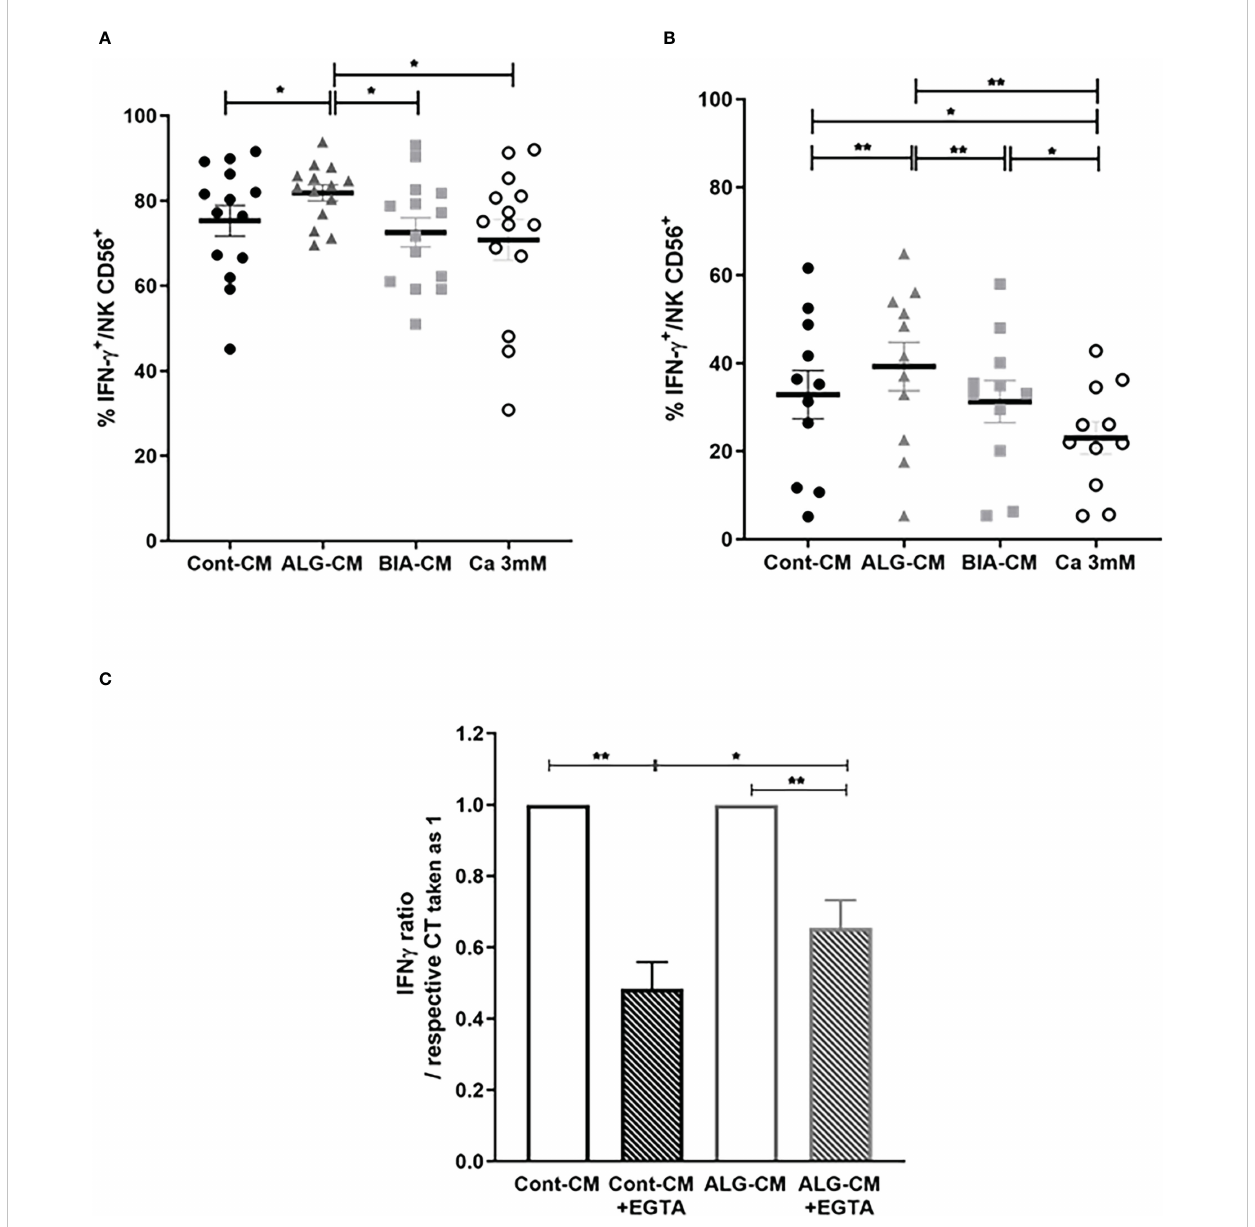
FIGURE 6 Effects of different sources of exogenous calcium on IFN- g production by NK cells. Flow cytometric detection of IFN- g production by puri fi ed CD56 + NK cells incubated for 24h in complete R10 medium with IL-2 (10ng/ml) plus IL-15 (100ng/ml) then stimulated with (A) PMA/IONO for 4h or (B) LPS (1µg/ml) for 18h in the presence of ALG-CM (grey triangle), BIA-CM (light grey square), and CaCl 2 3mM (white circle) versus conditioned control medium (black circle). Results show the % of positive intracellular staining detected on viable CD56 + cells of n=14 donors (for PMA/IONO stimulation) and n=11 (for LPS stimulation). (C) Ratio of LPS-induced-IFN- g expression in the presence of EGTA related to the respective controls in the absence of EGTA taken as 1 (white bars). Results are mean ± SEM (n=8), Wilcoxon paired test * p <0.05, ** p